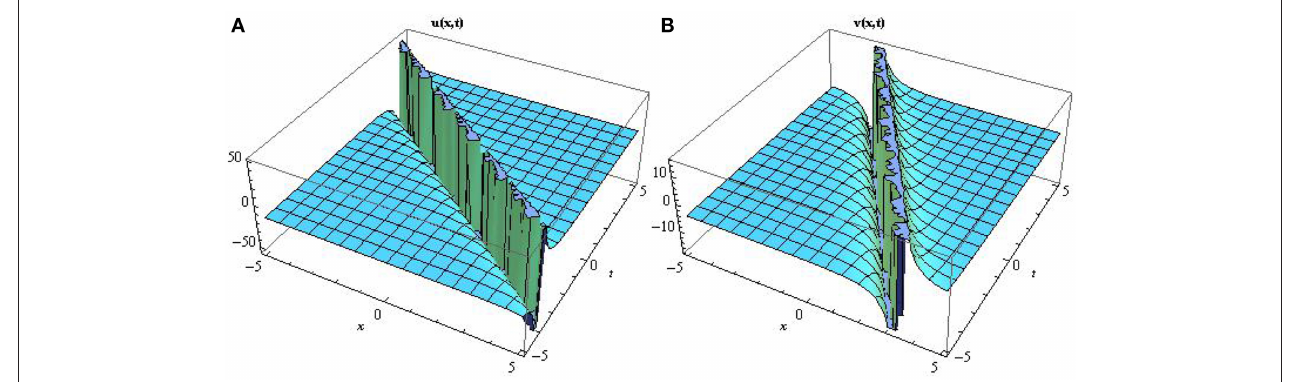
FIGURE 5 | Surface profile of the singular soliton solutions type-I I A and B mathematically represented by Equation (54) describing several terminologies in the field of mathematical physics by setting a 1 = 0.2, b 2 = 0.8, c 3 = 0.2, d = 1, e = 2, f =